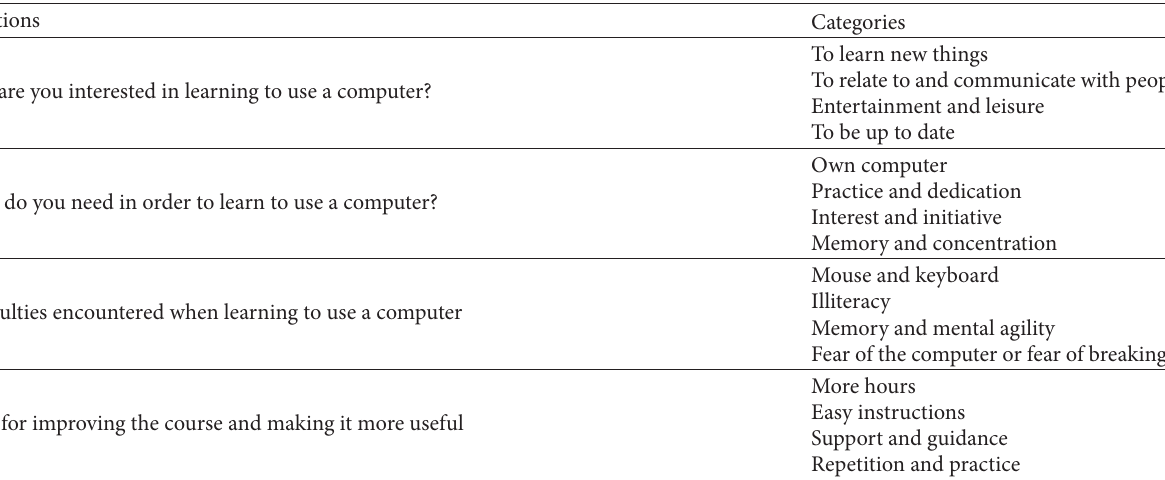
Table 3: List of categories according to the analysis ( 𝑁 = 140